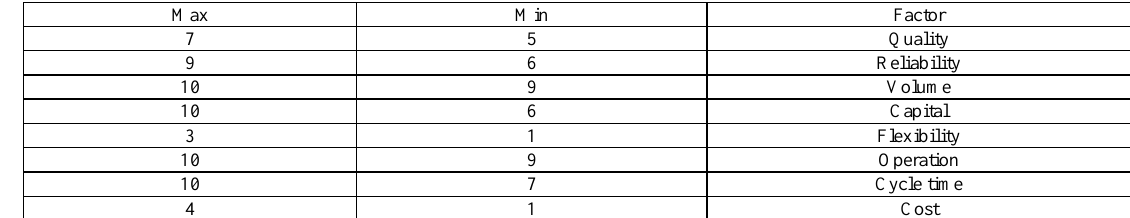
Table 1. The minimum and maximum scoring the